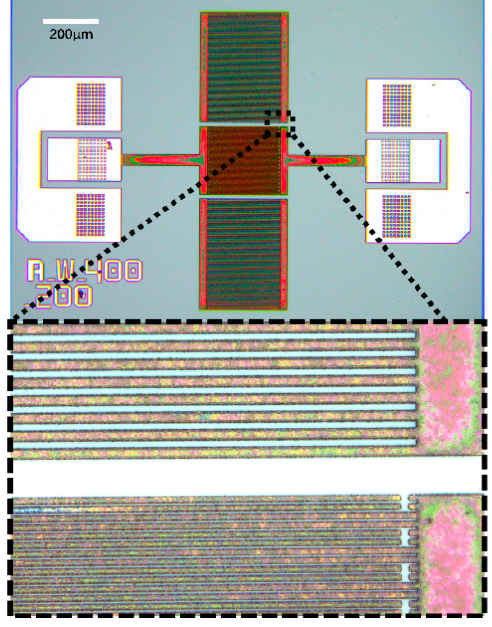
Figure 12. Microscope image and cross-view SEM image of the Lamb wave pressure sensor.